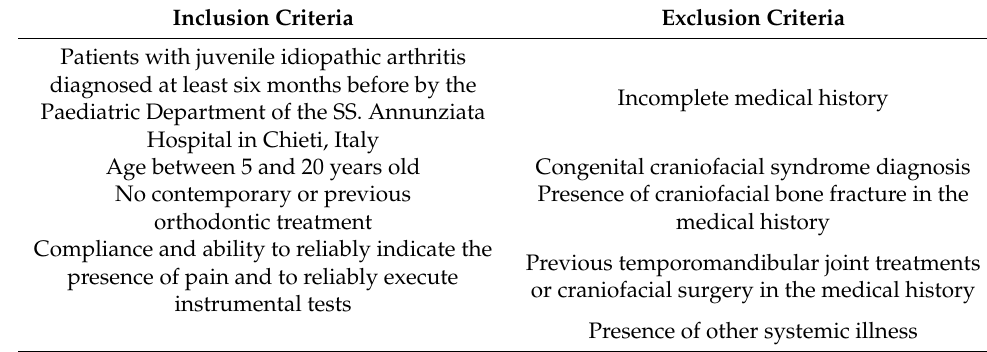
Table 1. Inclusion/exclusion